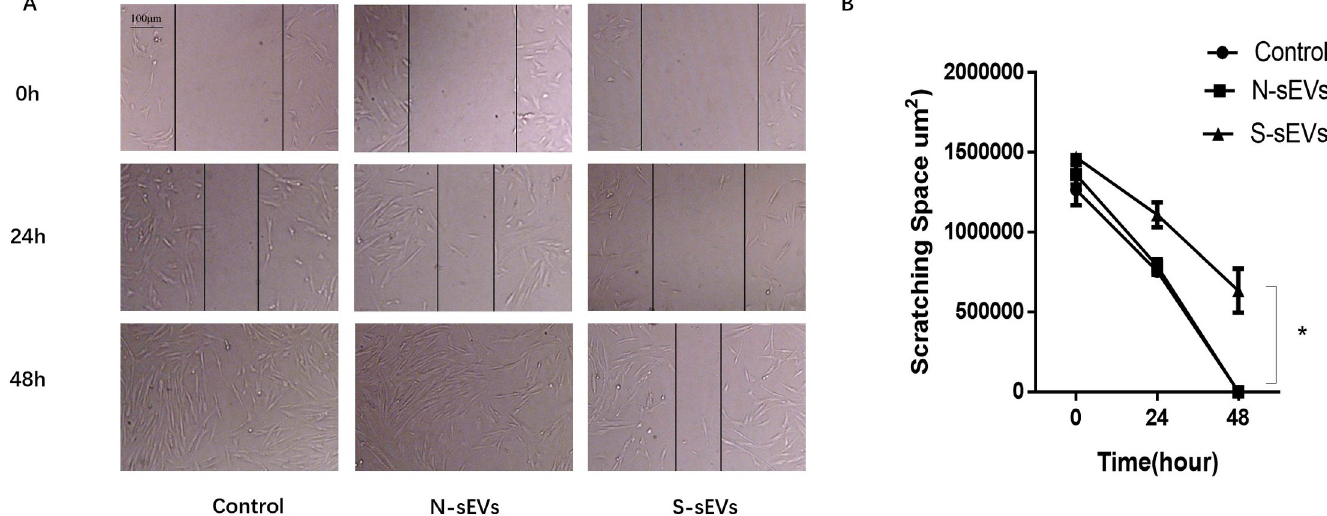
Fig 3. SUI-sEVs decreased the migration ability of primary cultured fibroblasts. (A) Fibroblasts were undergone scratch test, the wound healing changes were recorded between three groups at 0, 24 and 48h. (B) The variation of scratching space between groups is shown in the line chart. SUI-sEVs significant decreased the migration ability of primary cultured fibroblasts at 48h when compared to the cells in control group and treated with the non SUI-sEVs. N = 3 in each group. Data represented means ± SD of 3 independent experiments. � t-test P value < 0.05.